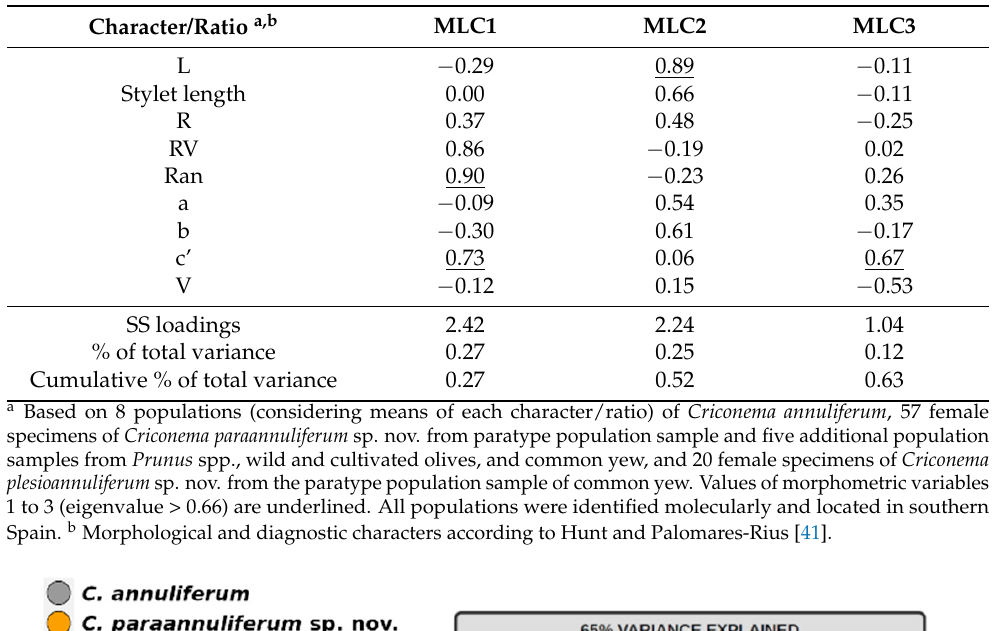
Table 2. Eigenvector and SS loadings of factors derived from nematode morphometric characters for the Criconema annuliferum -complex ( Criconema annuliferum , Criconema paraannuliferum sp. nov., Criconema plesioannuliferum sp. nov.).